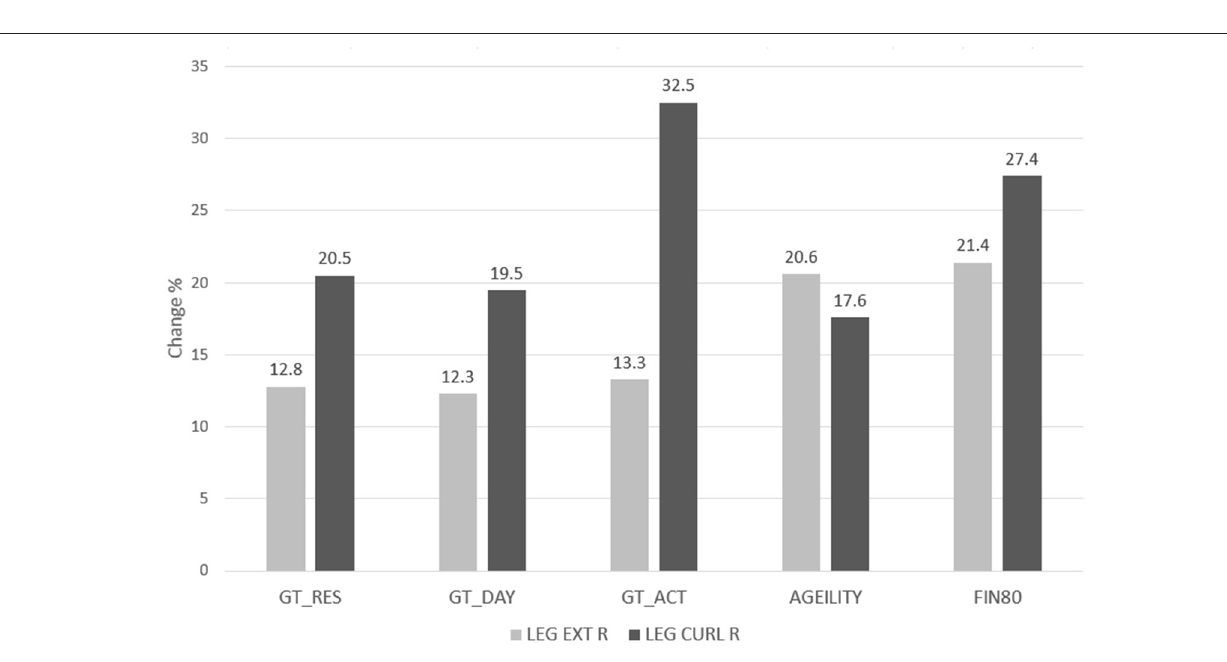
increase in muscle strength on resistance training for muscular strength in older adults (10). The results of Gym Tonic also corresponded to reference groups using identical technology and progressive